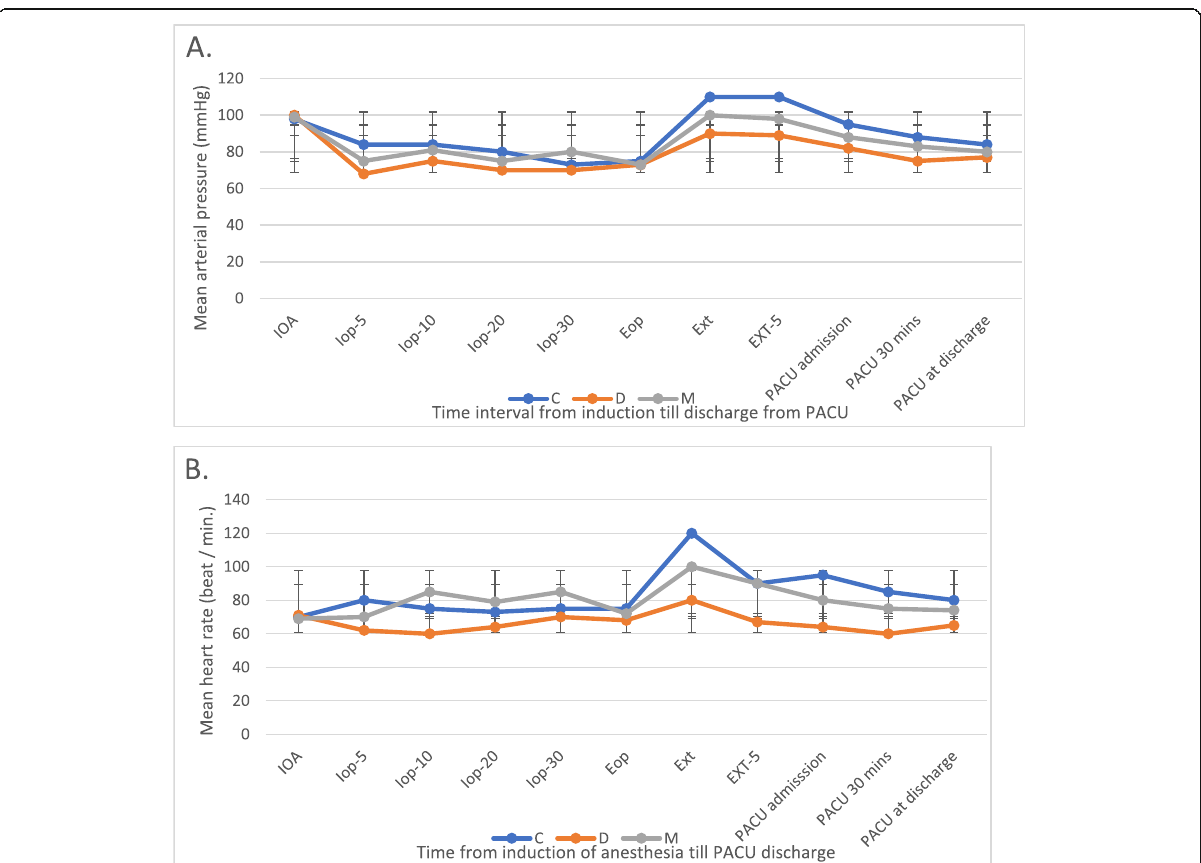
Fig. 2 Hemodynamic trends throughout anesthesia and emergence. A Mean arterial pressure. B Heart rate. IOA, induction of anesthesia; IOP-5, 5 min intraoperative; Iop-10, 10 min intraoperative; Iop-20, 20 min intraoperative; Iop-30, 30 min intraoperative; Eop, end of operation; Ext, extubation; Ext-5, 5 min after extubation; PACU admission, post-anesthesia care unit admission; PACU 30 min, 30 min in the post-anesthesia care unit; PACU at discharge, post-anesthetic care unit when the patient is ready to leave. C, control group; D, Dex group; M, magnesium sulfate group; linear C, trendline based on control group. Data shown as mean ± standard deviations